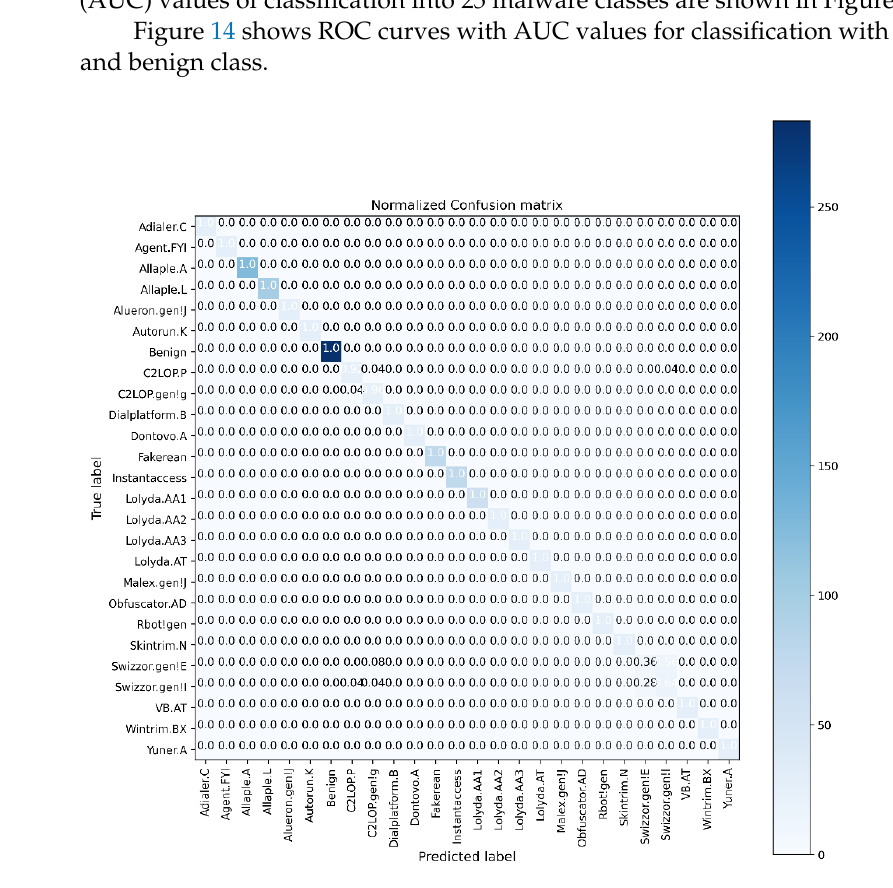
Figure 12. Normalized confusion matrix for classification with class balancing and benign class.